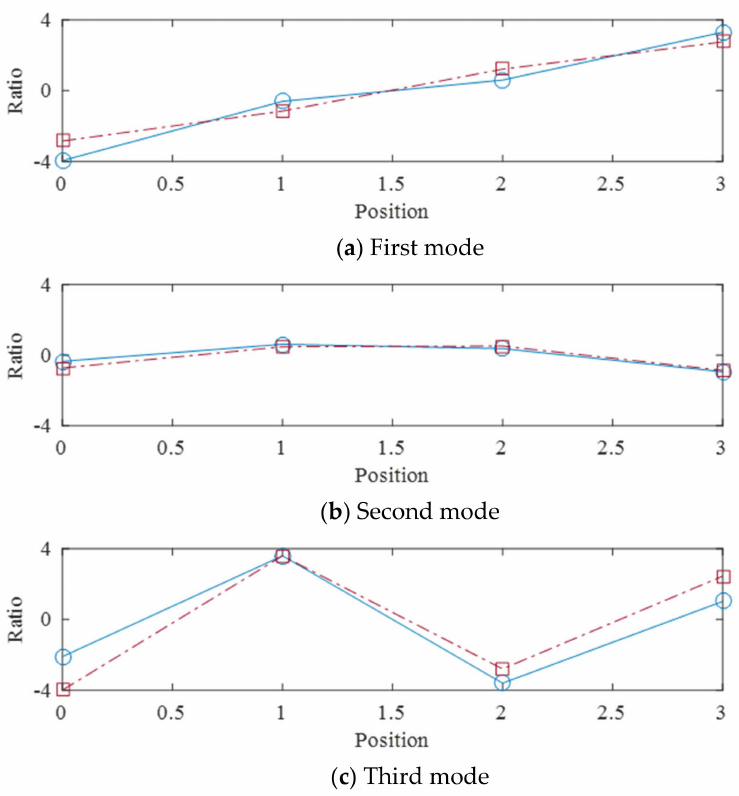
Figure 20. Mode shapes extracted from singular value decomposition (solid line: estimated, dashed line: